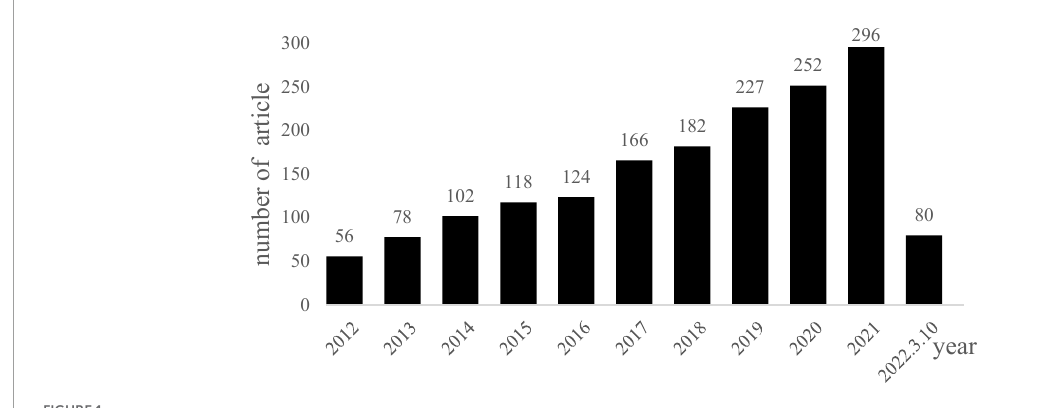
FIGURE1 Yearly articles related to cognitive training for Parkinson’s disease on PubMed.